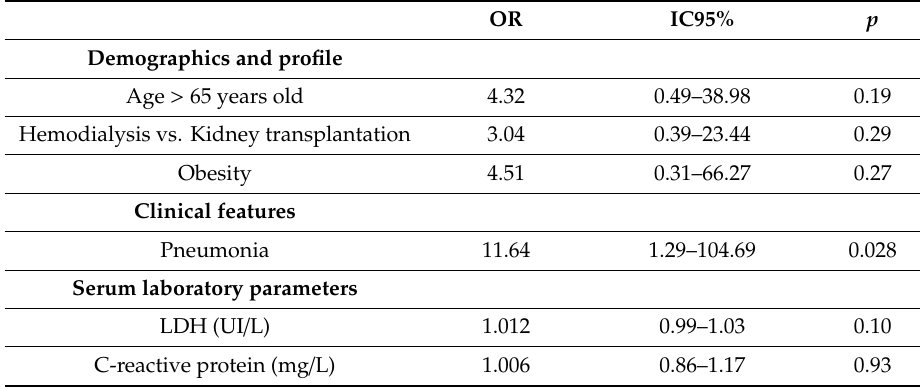
Table 4. Multivariate logistic regression analysis of factors associated with ( +